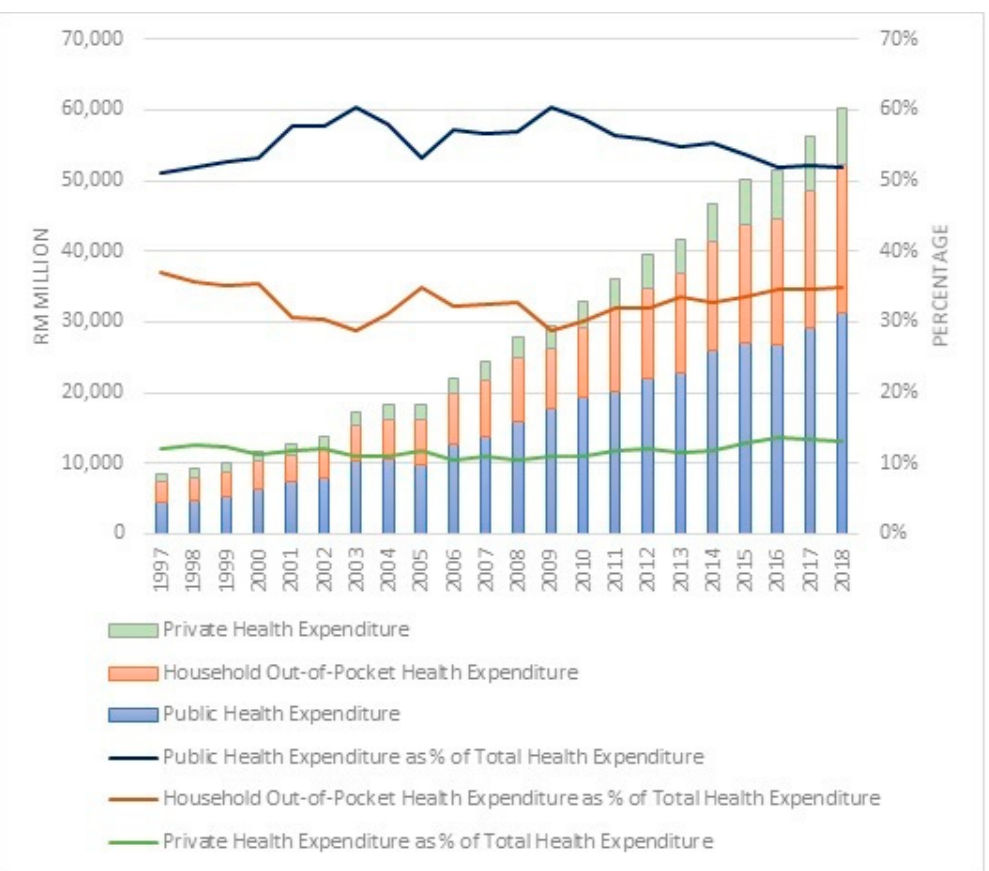
Figure 2. Health expenditure in Malaysia, from 1997 to 2018. Source: Malaysia National Health Accounts, Health Expenditure Report 1997–2018 (Ministry of Health, 2020).